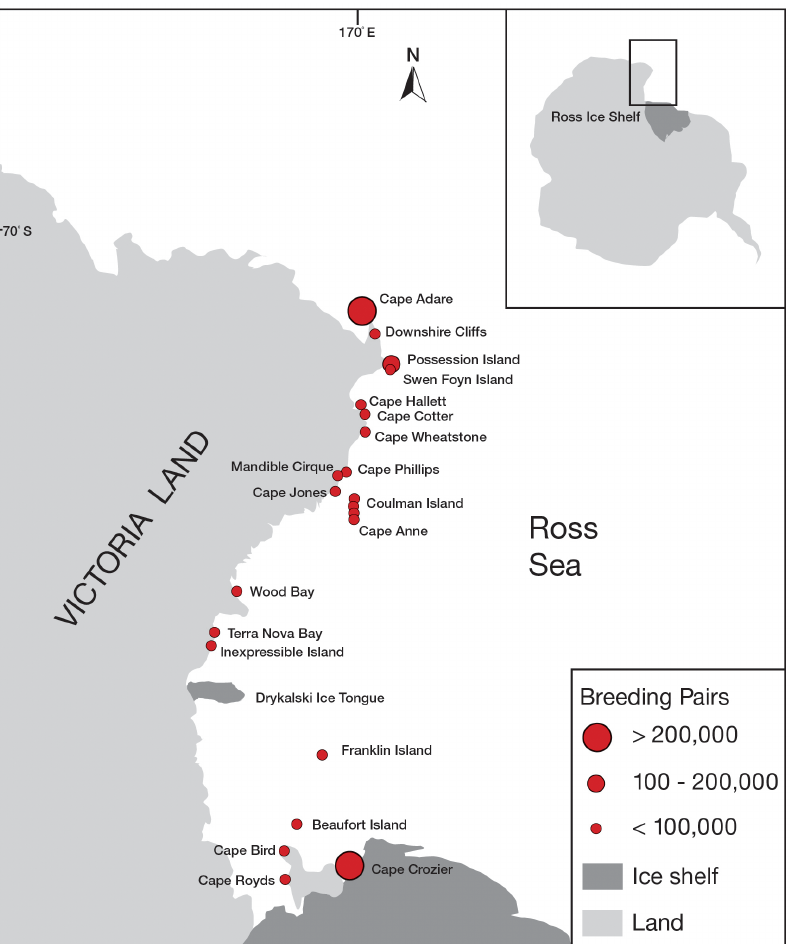
Figure 1. Distribution and size categories (based on 1981–2012 means) of Ade´lie penguin colonies from the western Ross Sea, Antarctica.